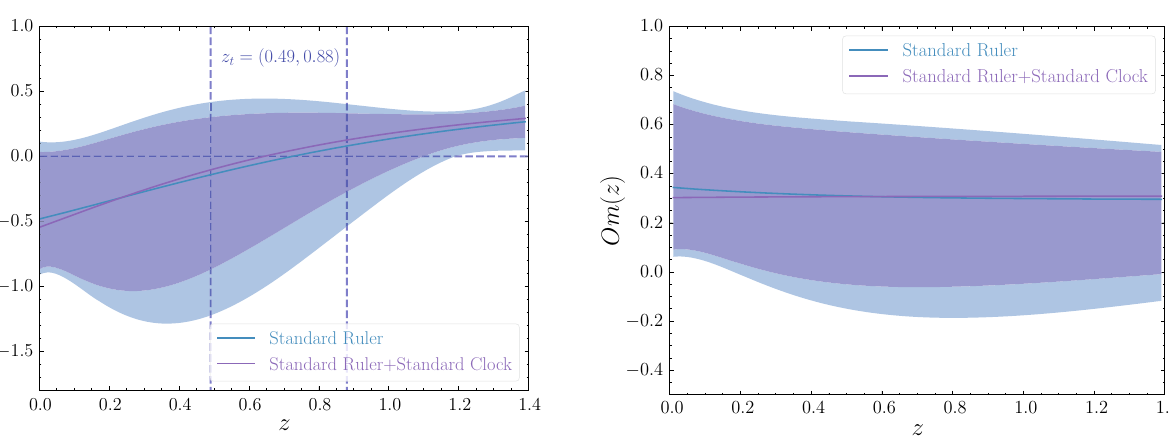
Fig. 4 Evolution of the deceleration parameter for the GEoS model Fig. 5 The evolution of Om ( z ) versus the redshift z for the GEoS fromthestandardrulerdata(blueline),aswellasthecombinedstandard model from the standard ruler data (blue line), as well as the combined ruler and standard clock data (purple line). The 1 σ uncertainties are, standard ruler and standard clock data (purple line). The 1 σ uncertain- respectively, denoted by blue and purple shades. The dashed vertical ties are, respectively, denoted by blue and purple lines stand for the interval 0 . 49 ≤ z t ≤ 0 . 88, which corresponds to ± 1 σ of one of the values for z t estimated by Cunha [70]